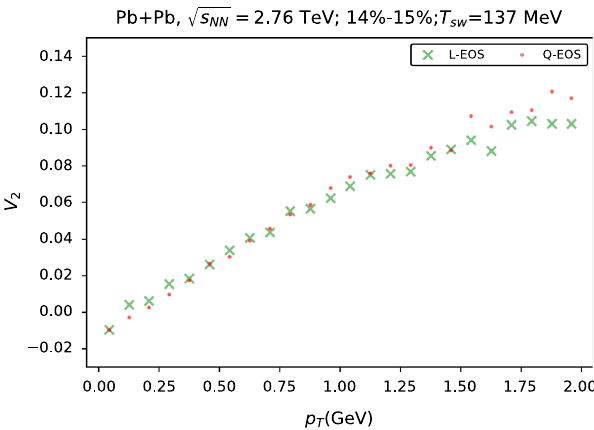
Fig. 10 All-events-fine-averaged normalized p T spectra d N / N d y d p T (left panel) and elliptic flow v 2 as a function of p T (right panel) of the training datasets in Table 1 with two EoSs. The